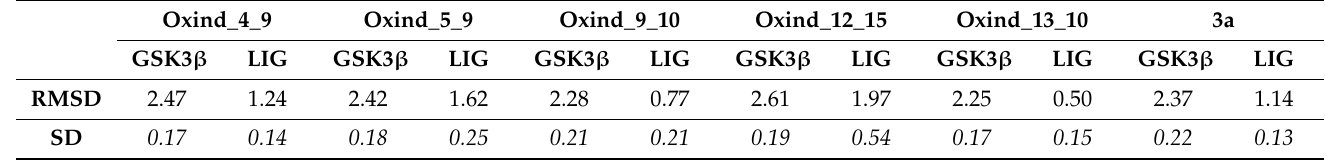
Table 3. The average values of RMSD for ligands and enzymes for all steps used during structural analysis. The values in italics represent standard deviations (SDs). The LIG captions represent values characterizing appropriate ligand molecules in considered